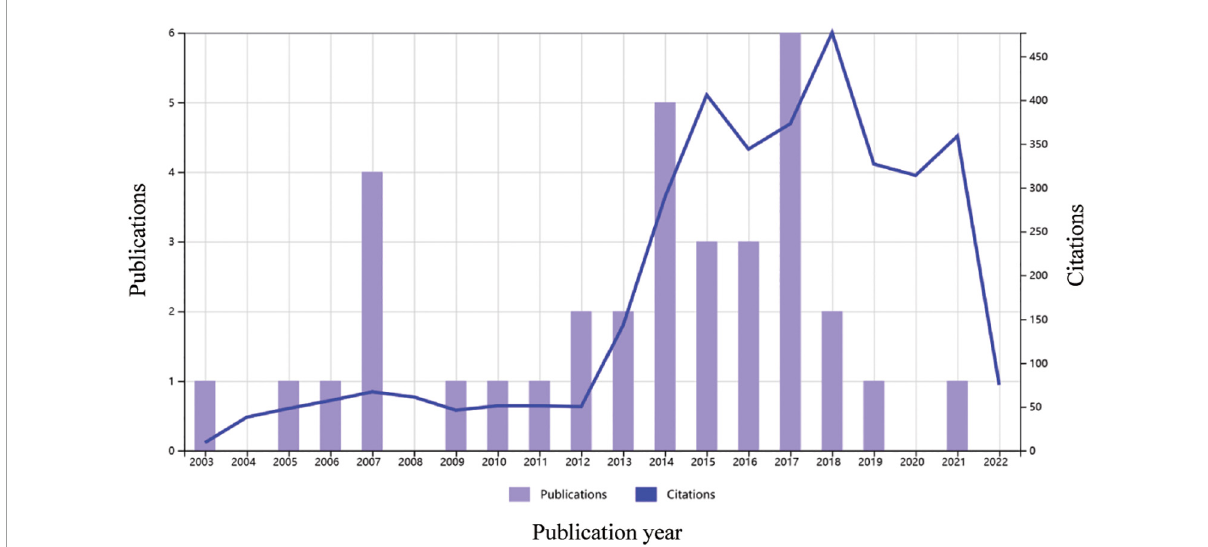
FIGURE2 Times cited and number of publications over time related to cardiac regenerative therapy in patients with ischemic heart disease. Data source: Web of Science, searched with the topics “Ischemic cardiomyopathy” AND “Regenerat” and then refined by document types “Articles” and “Clinical Trial,” MeSH headings of “Humans” and “Treatment Outcome,” and excluding document types “Retracted Publications” and “Publication with Expression of